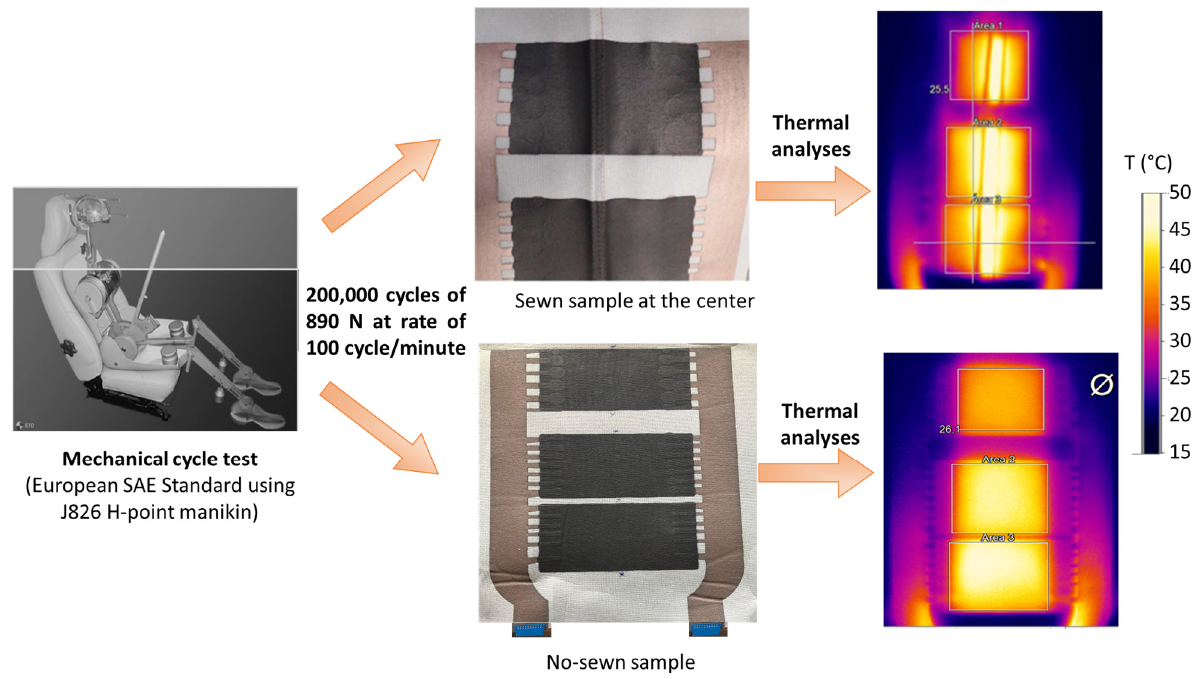
Figure 18. Thermal analyses of both sewn and non-sewn coated fabrics after several mechanical-cycle aging tests.